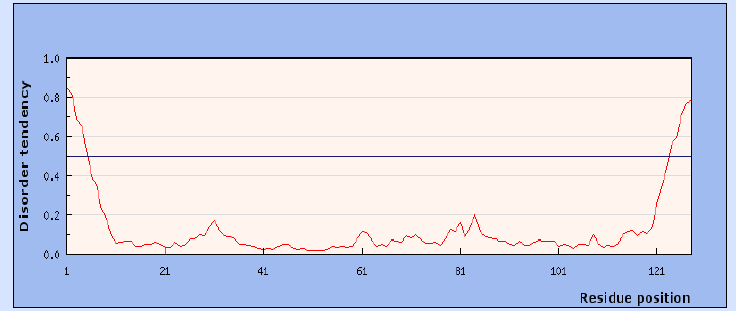
Figure 2. Intrinsic disordered regions (IDRs) of PV2A pr °. Grey line indicating threshold line. The regions above the line represents the disordered regions. X-axis: Residue position, Y-axis: Disorder tendency score